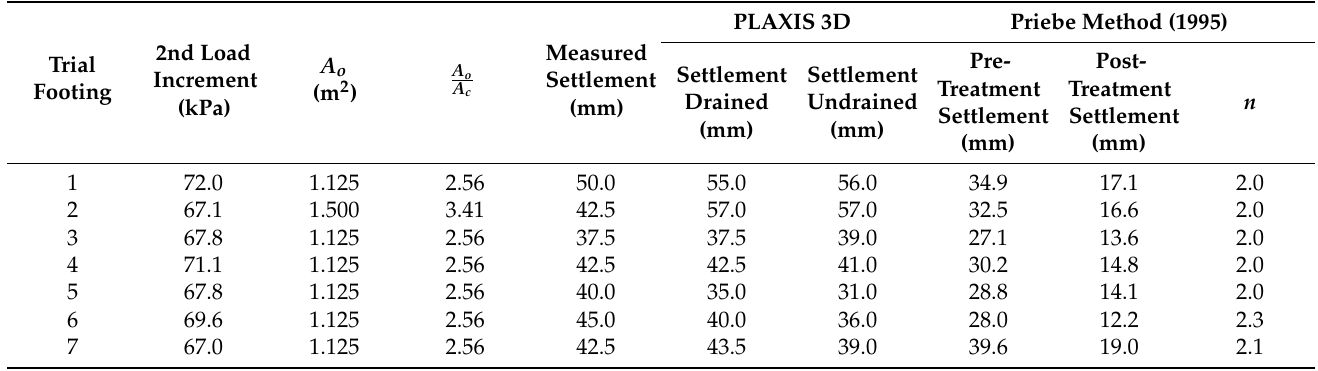
Table 8. Measured [36], predicted settlement with PLAXIS 3D and estimated settlement with the Priebe (1995) method for the trial footings under the second load